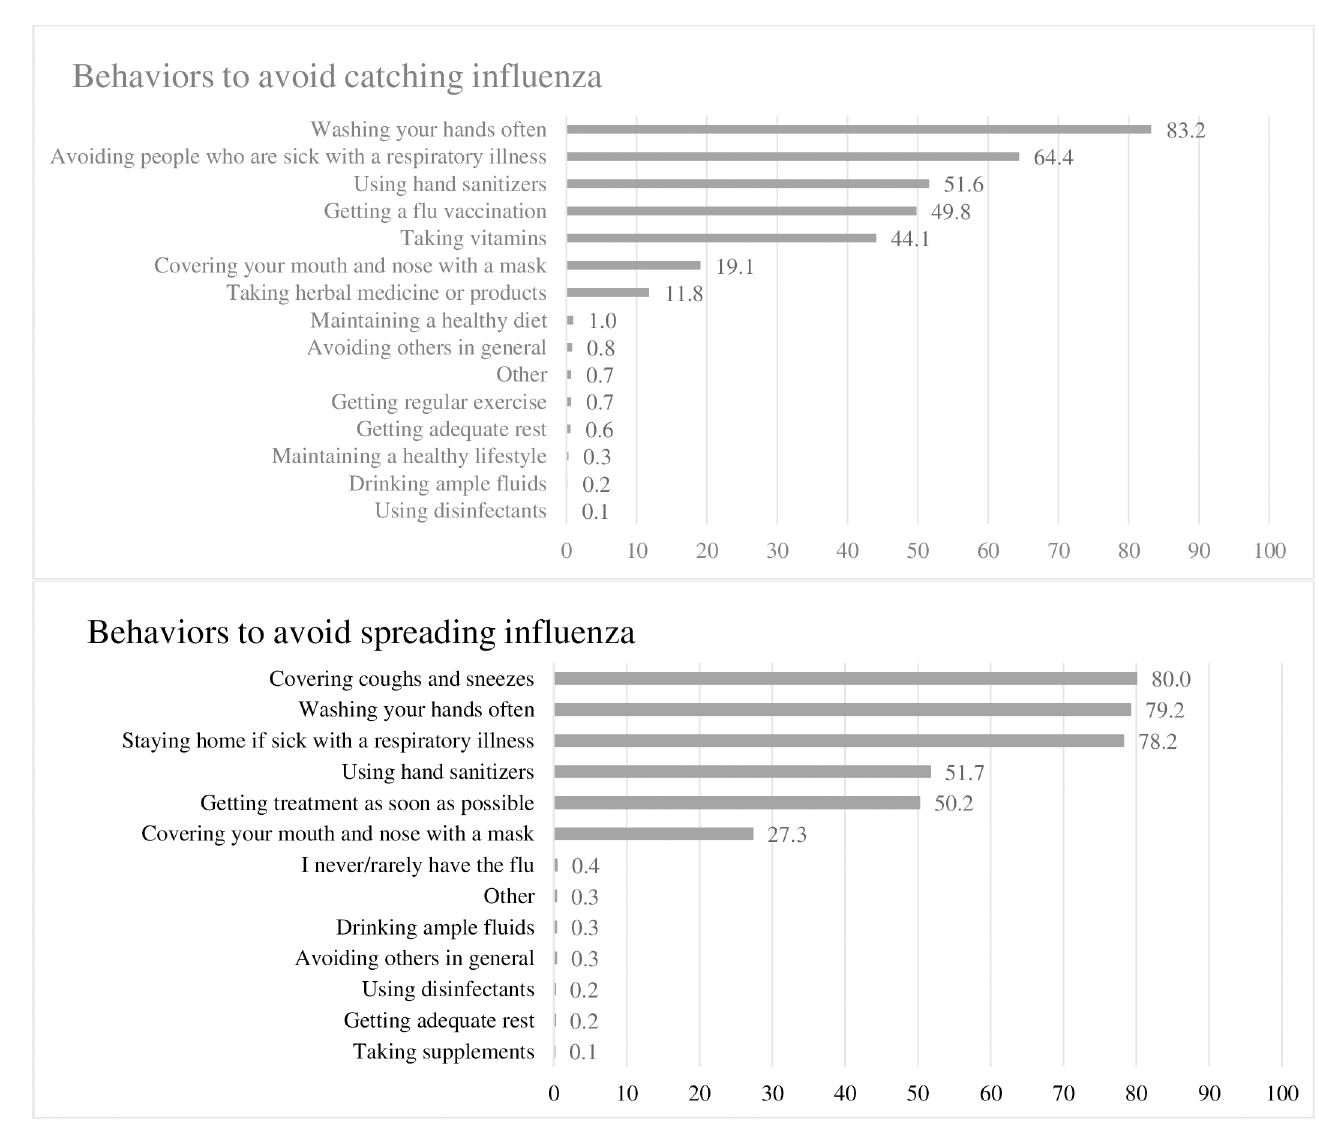
Fig 1. Preventive behaviors used by adults as precautions taken to avoid catching influenza or spreading